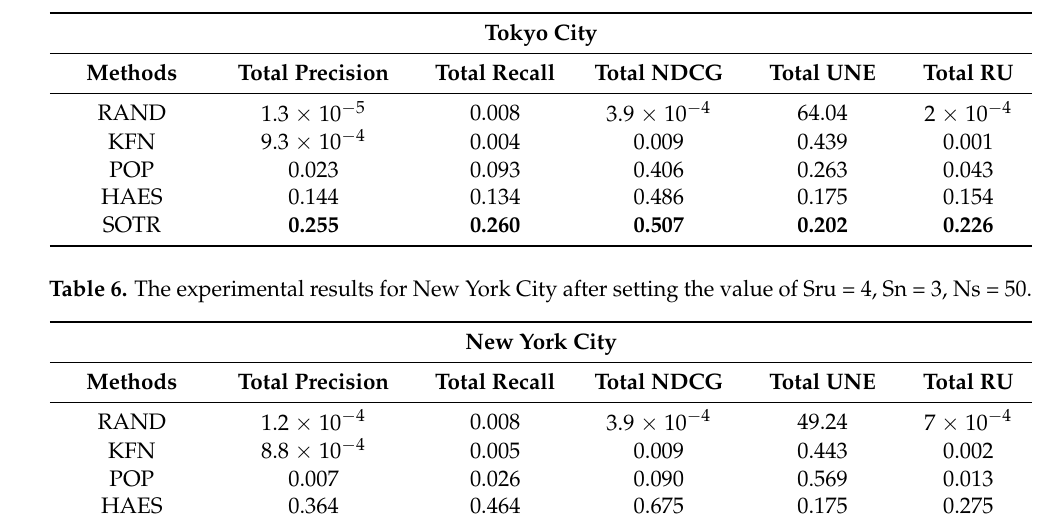
Table 5. The experimental results for Tokyo City after setting the value of Sru = 4, Sn = 3, Ns = 50.